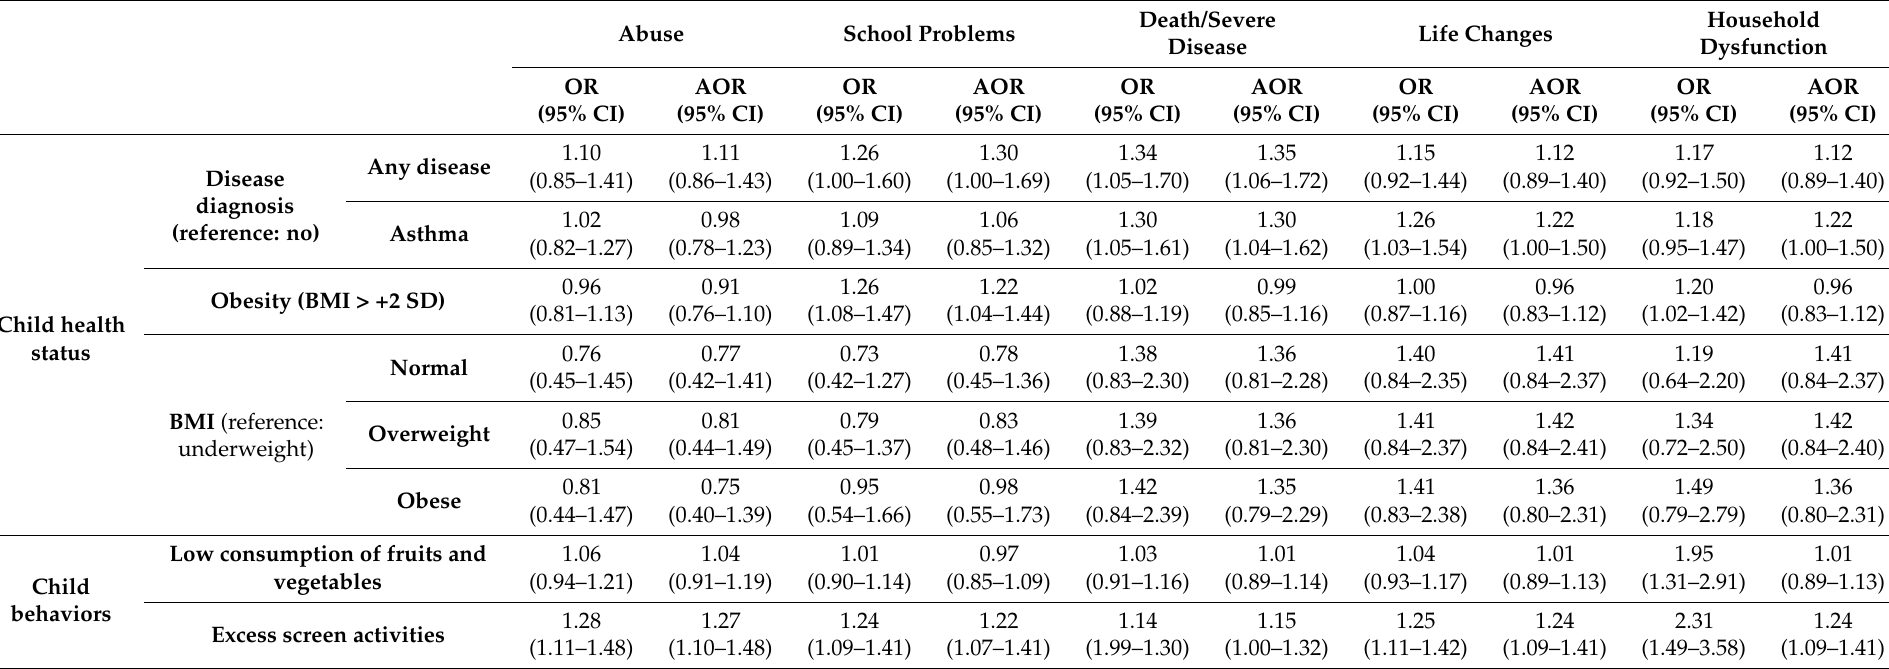
Table 3. Associations (Odds Ratio and 95% Confidence Interval, OR (95%CI)) of child health status and behaviors with each dimension of adverse childhood experiences (ACEs) in the Generation XXI ( n =